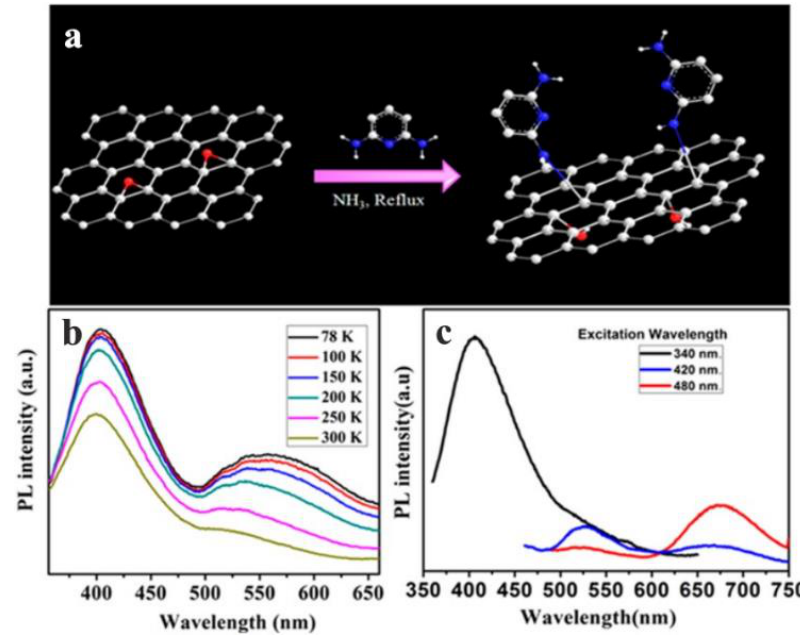
Figure 7. ( a ) Synthesis scheme of DAP-fGO. ( b ) Temperature-dependent and ( c ) excitation-dependent PL spectra of DAP-fGO films. Reprinted with permission from [55]. Copyright 2016, American Chemical Society.